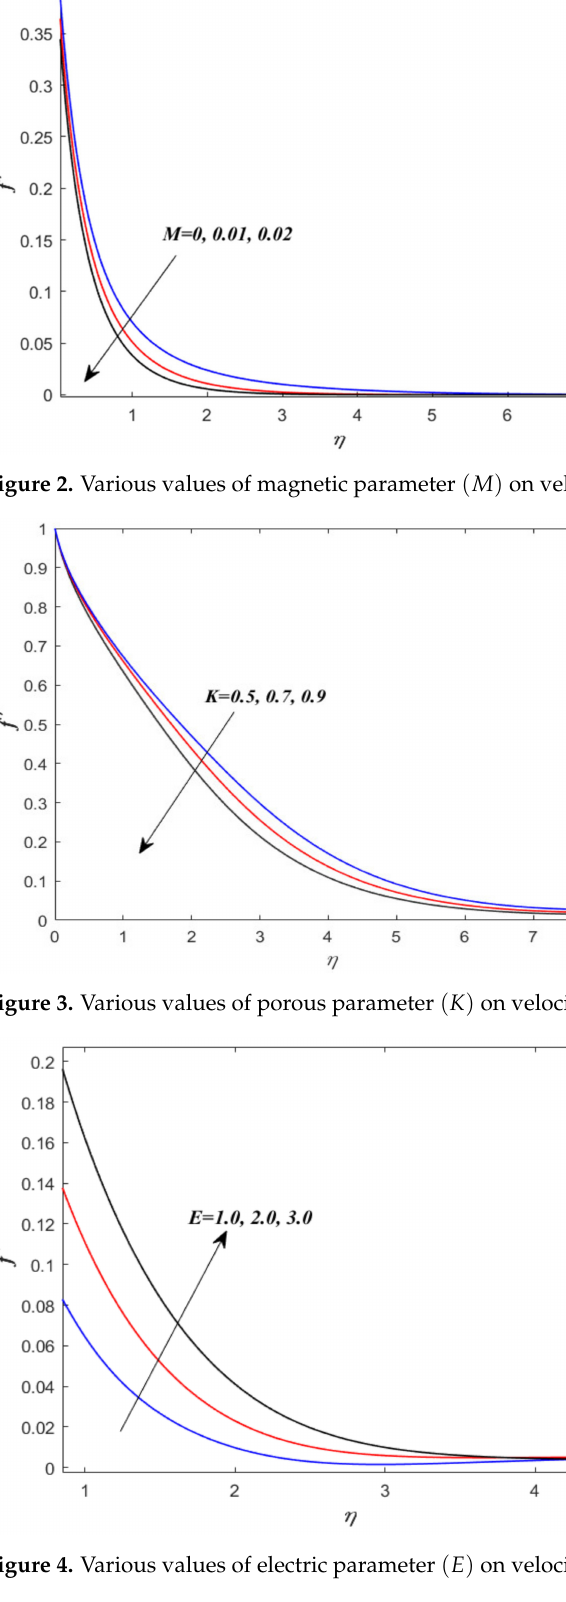
Figure 4. Various values of electric parameter ( E ) on velocity f (cid:48) ( η )